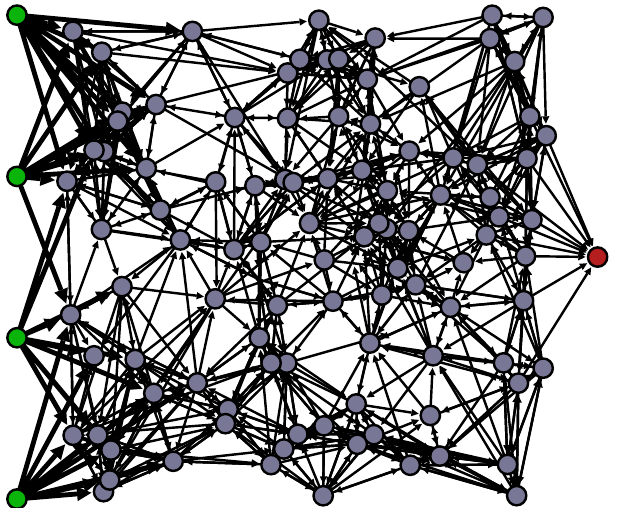
Figure 1. Network architecture. Network with one hundred neurons in the network (gray neurons). The four input neurons (green) on the left are labeled 1 to 4 (top to bottom) and are connected to the network. On the right is the output neuron (red) which senses incoming signals from its ten nearest nodes. The strength of the synapses is indicated by their